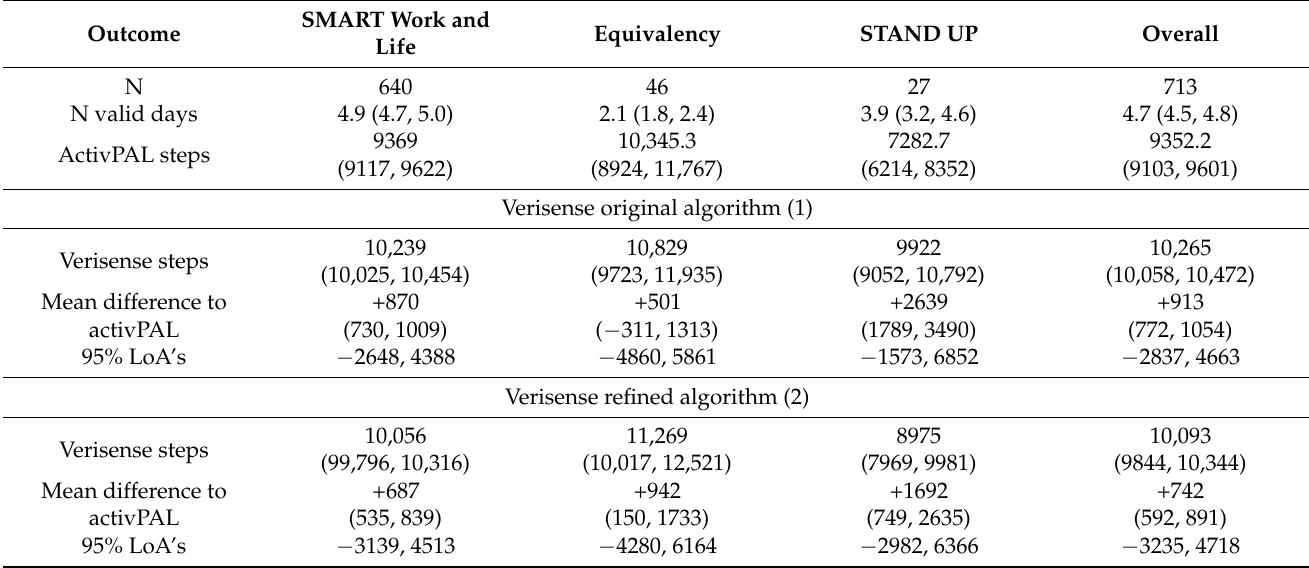
Table 3. Agreement between steps derived by the activPAL and steps derived by the Verisense algorithms applied to wrist accelerometer data.